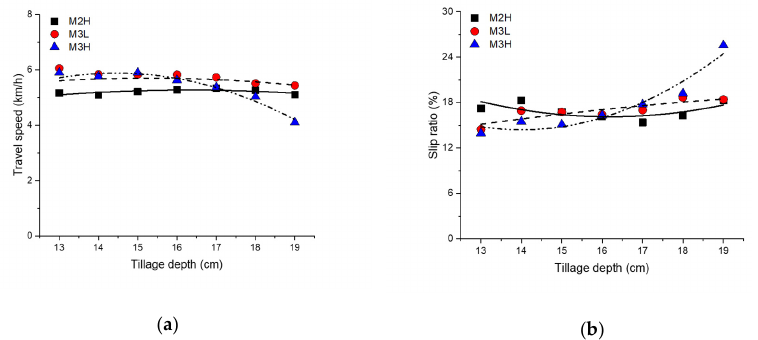
Figure 7. Mean values of ( a ) travel speed and ( b ) slip ratio according to tillage depth and gear selections during plow tillage. Table 5. Mean travel speed (km/h) according to tillage depth and gear selection (GS).